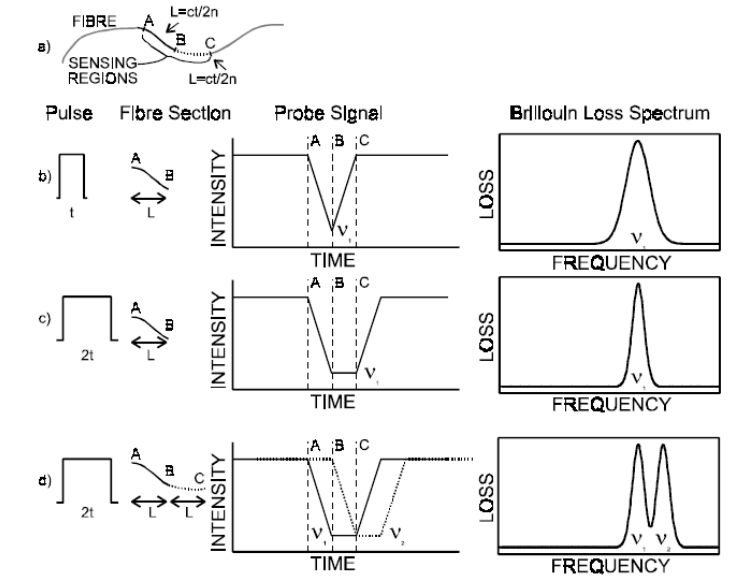
Figure 3. Time-domain waveforms and Brillouin loss spectra for various pulse widths [29] (Copyright © 1999 IEEE, Reprinted with